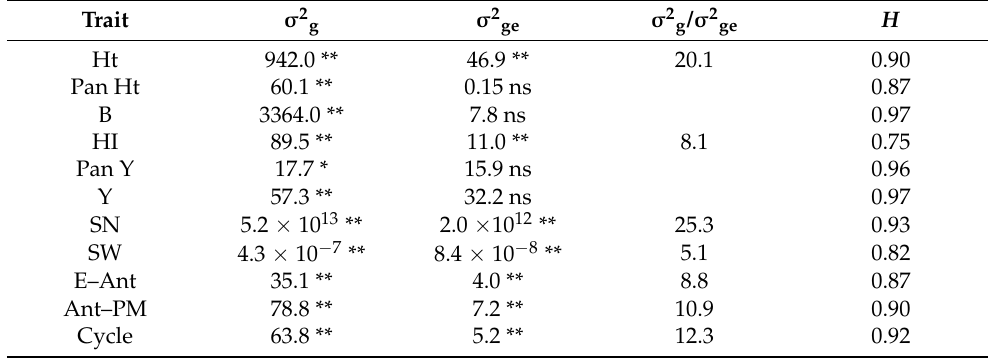
Table 2. Relative contribution of estimated variance components and broad-sense heritability ( H ) for 11 phenotypic traits measured in 117 genotypes of quinoa across two years in Faisalabad.